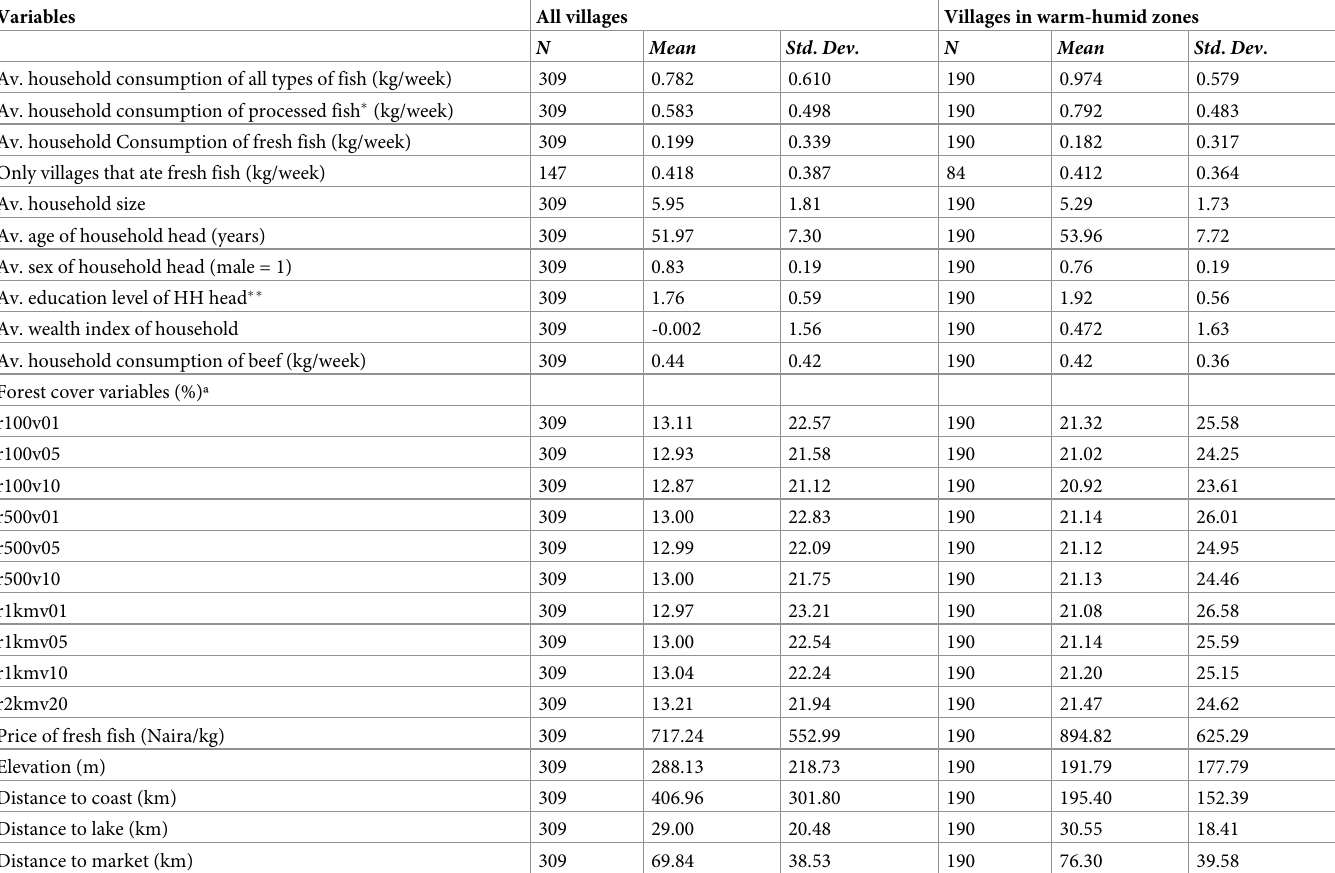
Table 2. Descriptive statistics including mean and standard deviation of dependent and independent variables for all villages and for villages in warm humid and warm sub-humid zones.